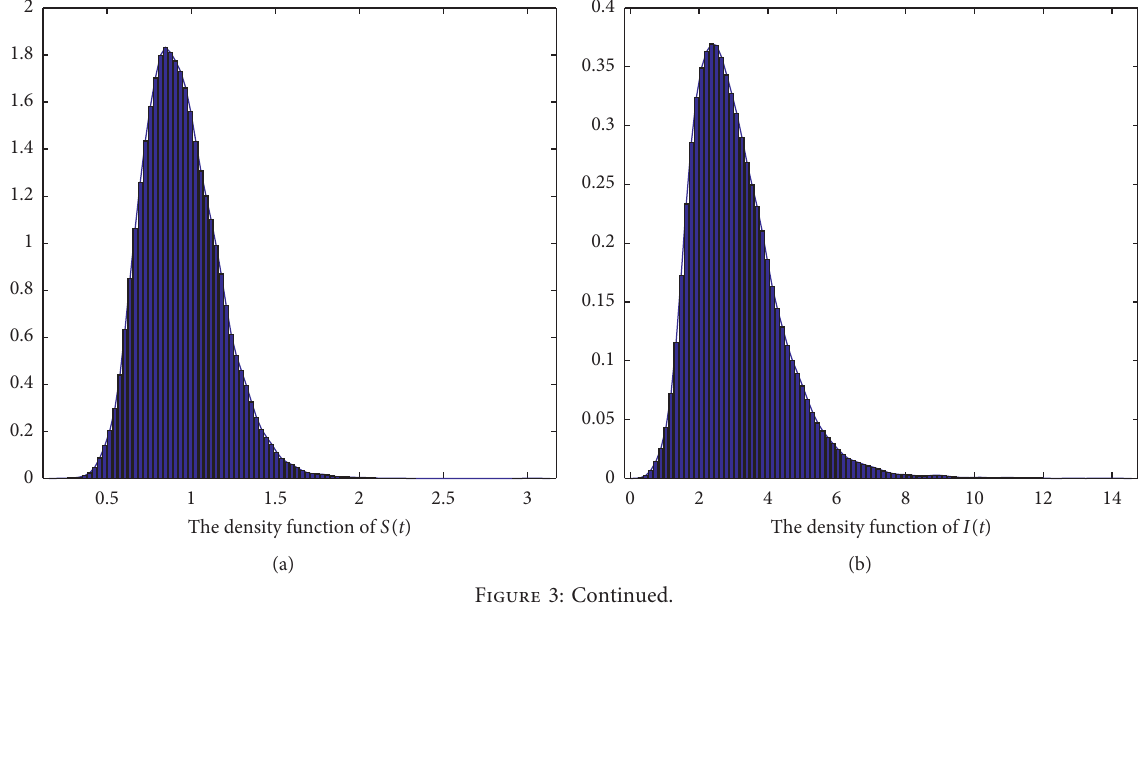
Figure 2: (a) The solution of deterministic system (1). (b) The solutions of stochastic system (4), where σ (c) The solution of stochastic system (4), where σ